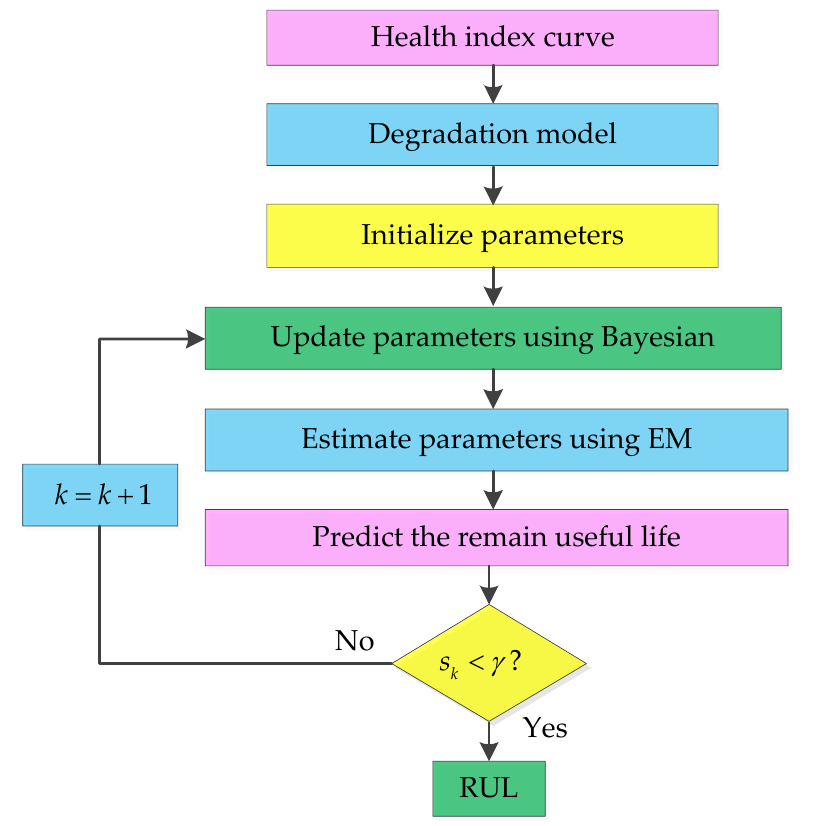
Figure 2. Flow chart of exponential degradation model.